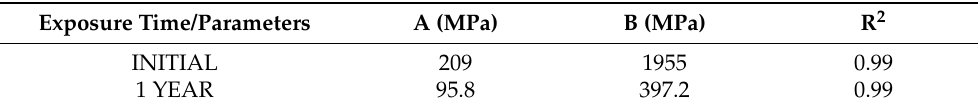
Table 5. Defining parameters of the storage modulus evolution with the percentage of glass fiber volume depending on exposure time.